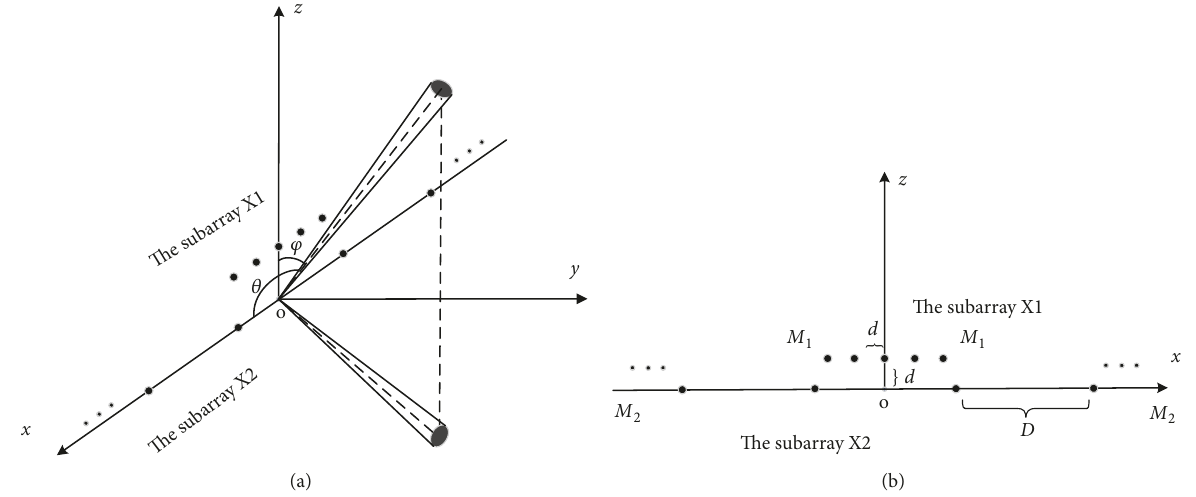
Figure 1: (a) Illustration of the nested array configuration in three dimensions; (b) Illustration of the nested array configuration on xoz plane.